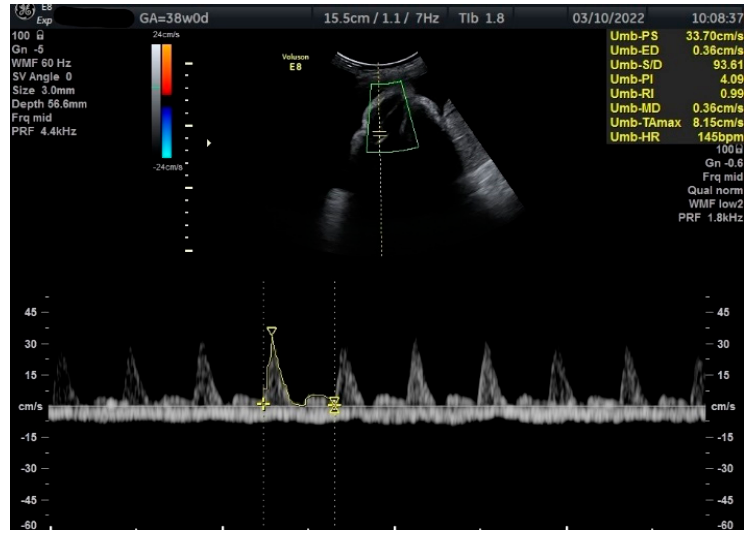
Figure 2. Doppler measurement at 38 + 0 weeks of normal TA-PI (measured manually).